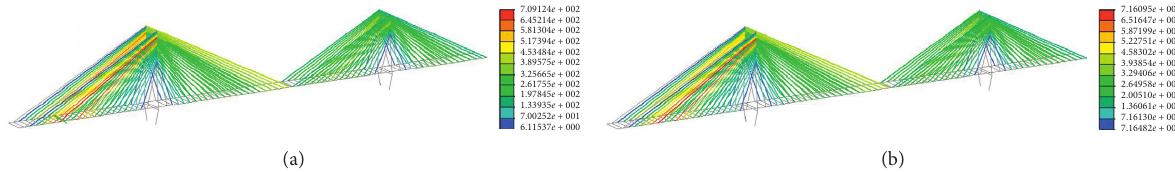
Figure 16: Cable force distributions for the emergency rescue cases (unit: tonf): (a) repair scheme 1 and (b) repair scheme 2.